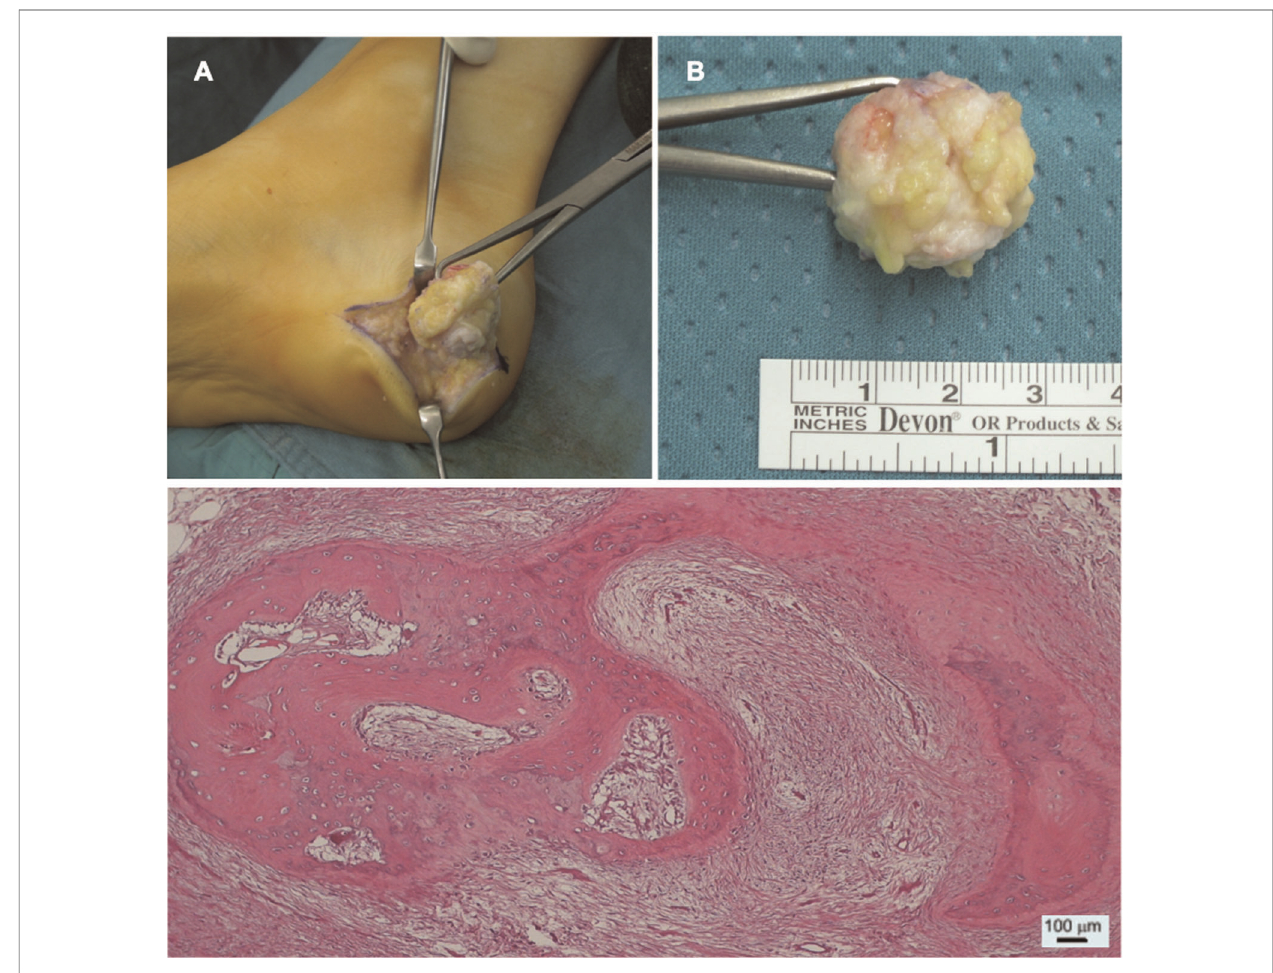
FIGURE 2 | ( A ) Intraoperative image of the excision of the mass. ( B ) Picture of the sample measuring approximately 2.5×1.5×2 cm. ( C ) Section of the lesion as seen with optic microscopy and Hematoxylin & Eosin staining. The specimen shows “ mixed fi brous-adipose dermo-epidermal tissue with foci of stromal osseous metaplasia ” , as con fi rmed also by pathology